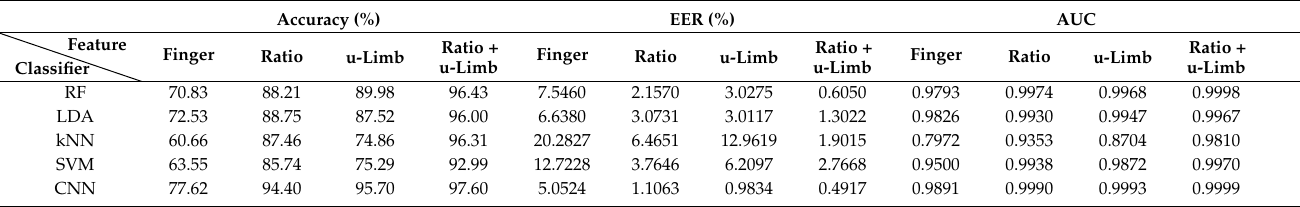
Table 1. Accuracy, EER, and AUC of discriminative classification models according to feature